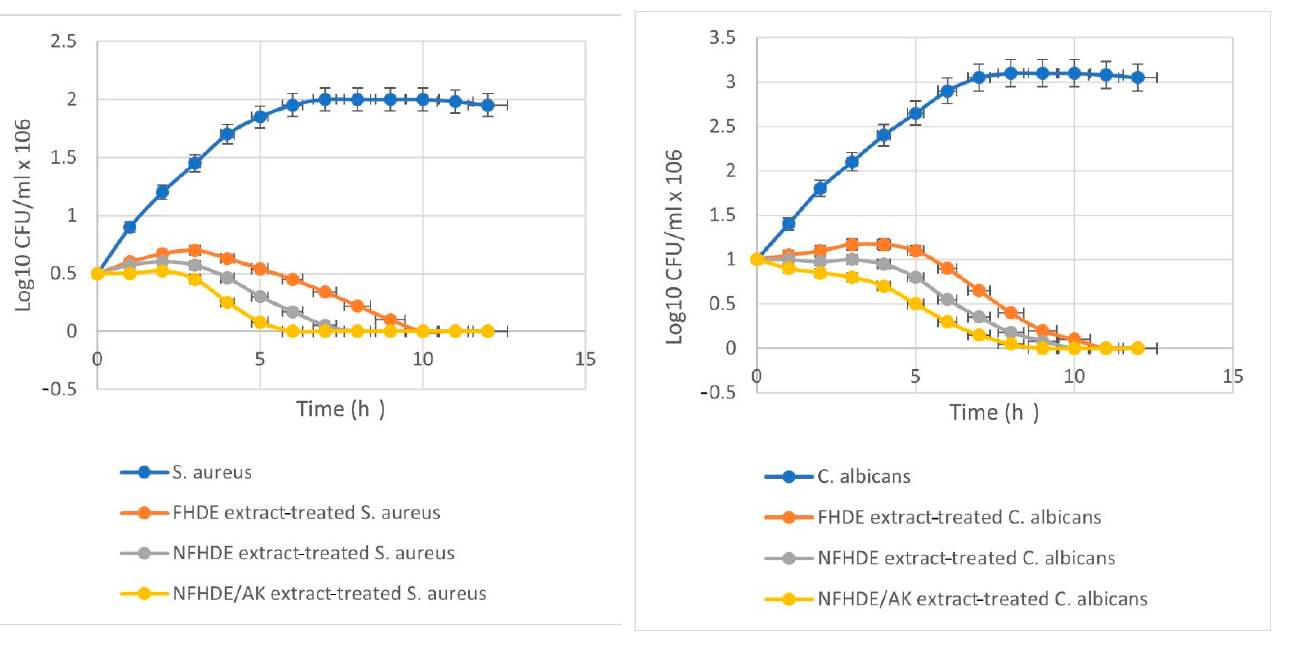
( b ) Figure 6. Transmission electron micrographs of NFHDE/AK-treated S. aureus ( a ) and C. albicans ( b ) cells. 3. Materials and Methods